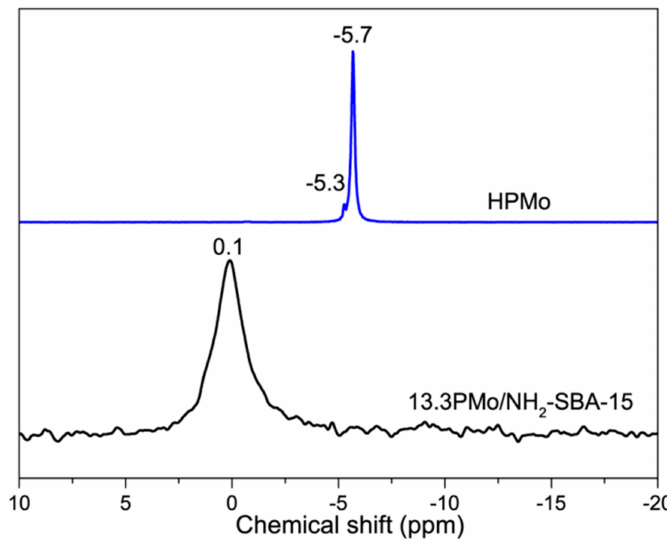
Figure 3. 31 P MAS NMR spectra of H 3 PMo 12 O 40 · nH 2 O and 13.3PMo / NH 2